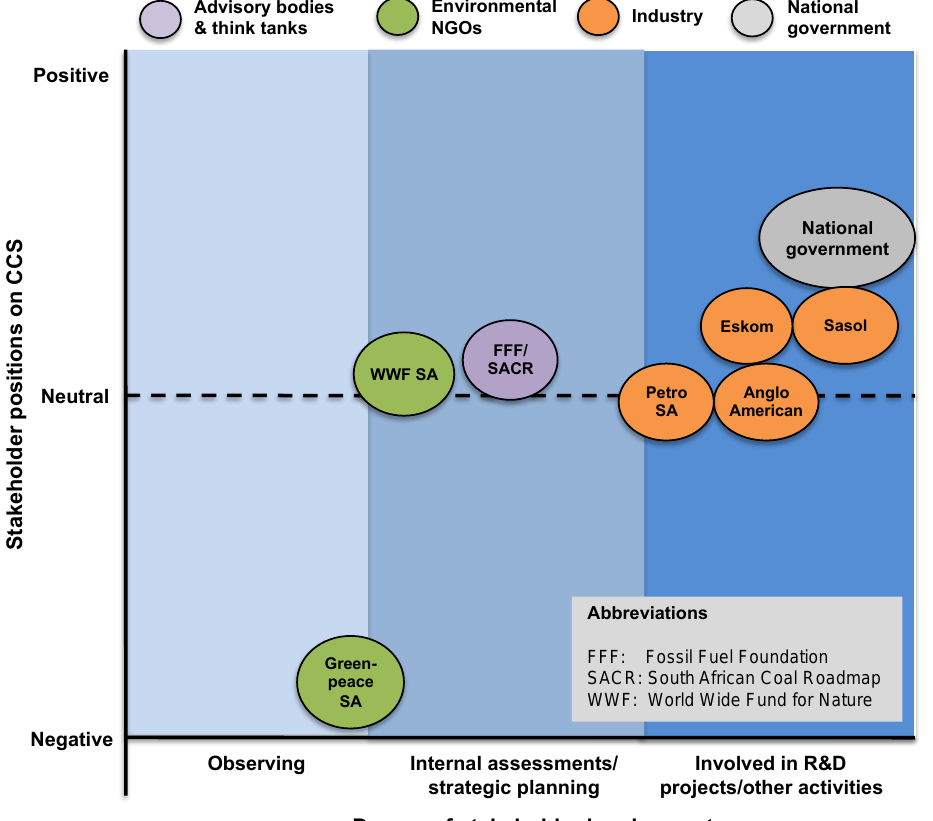
Figure 10 . Constellation of key CCS stakeholders in South Africa . Figure 10. Constellation of key CCS stakeholders in South